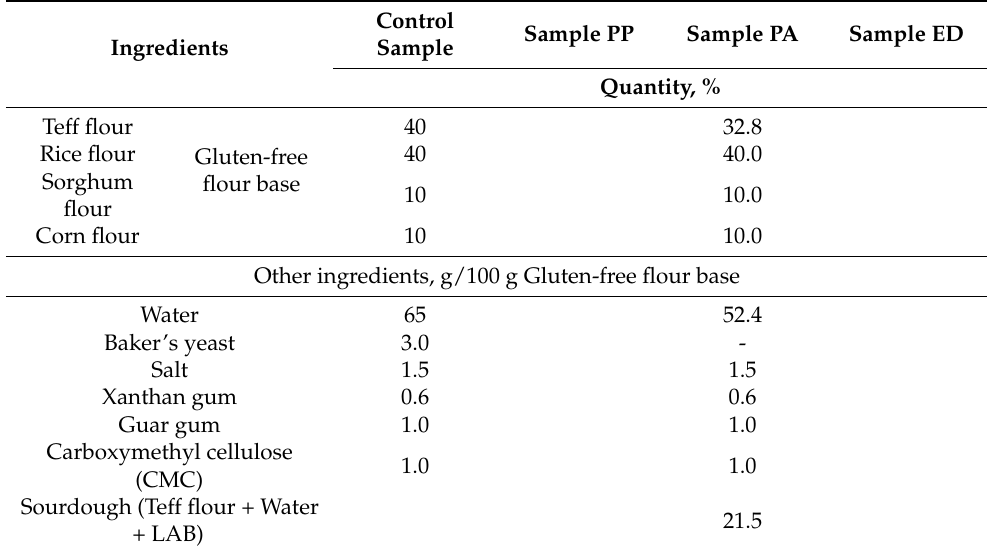
Table 2. Composition of gluten-free breads with sourdoughs and control